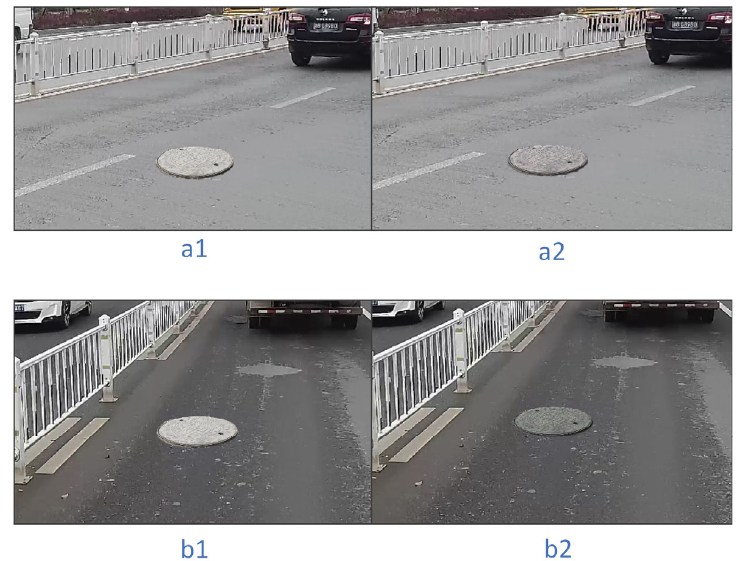
Figure 9. The situation of using or not using the image harmonization algorithm for the same manhole cover in different scenes, where ( a1 , b1 ) do not use the image harmonization algorithm, and ( a2 , b2 ) use the image harmonization algorithm.